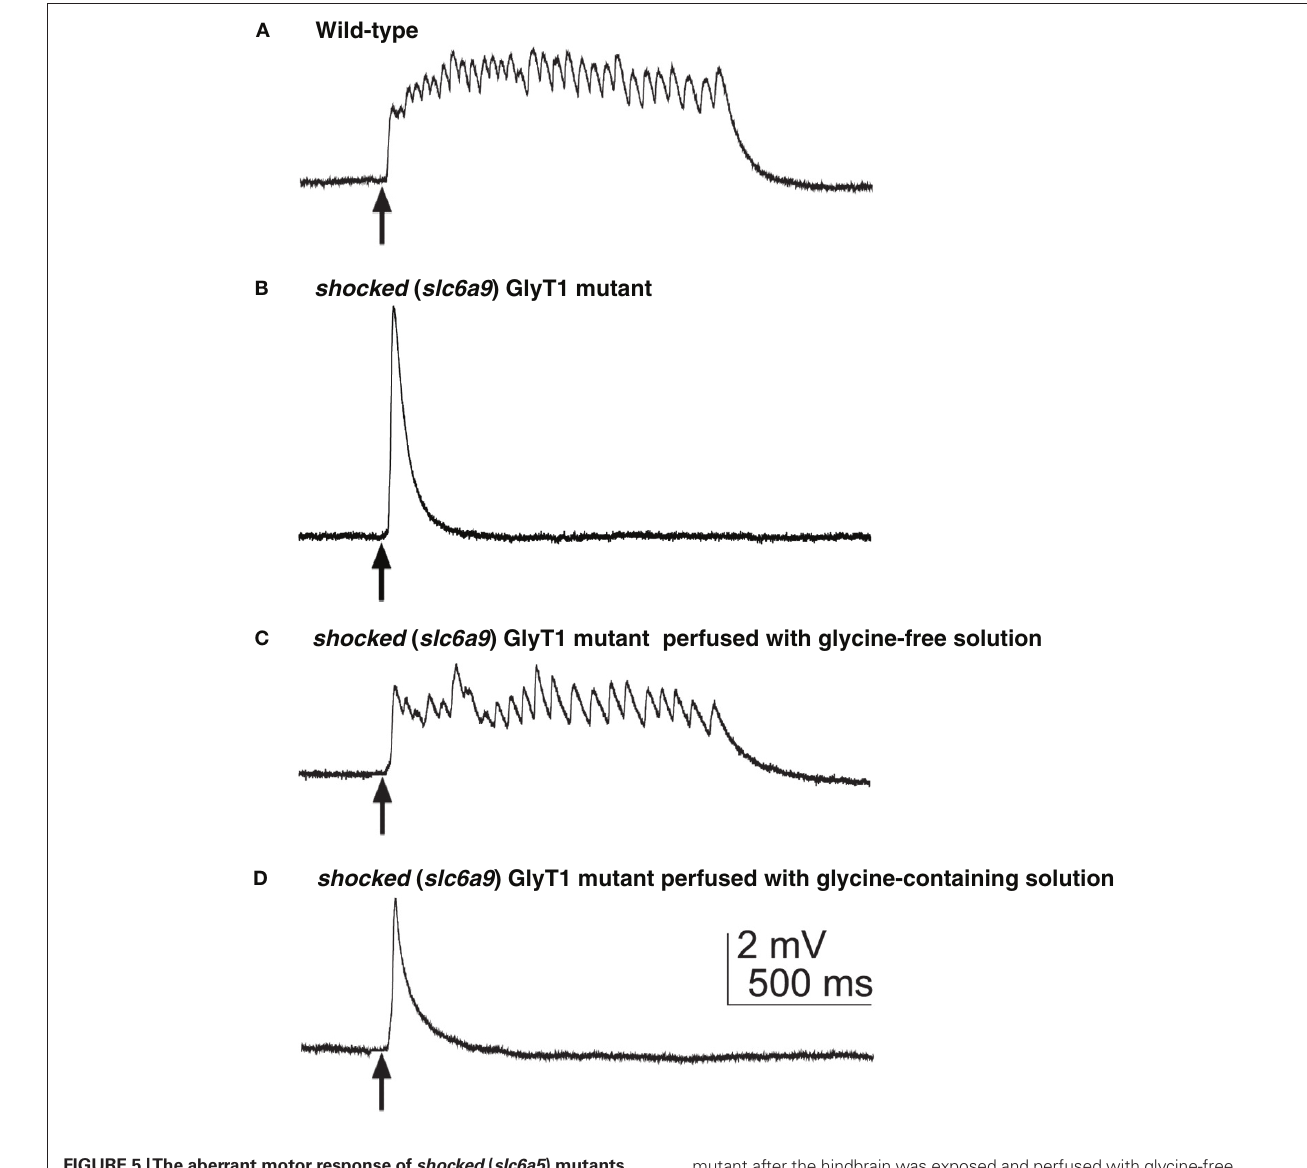
mutant after the hindbrain was exposed and perfused with glycine-free solution demonstrated rhythmic depolarizations similar to fi ctive swimming. (D) Muscle recording from the same sho embryo as in (C) after switching the perfusion from glycine-free solution to saline containing 0.2 mM glycine again exhibited the aberrant response characteristic of sho